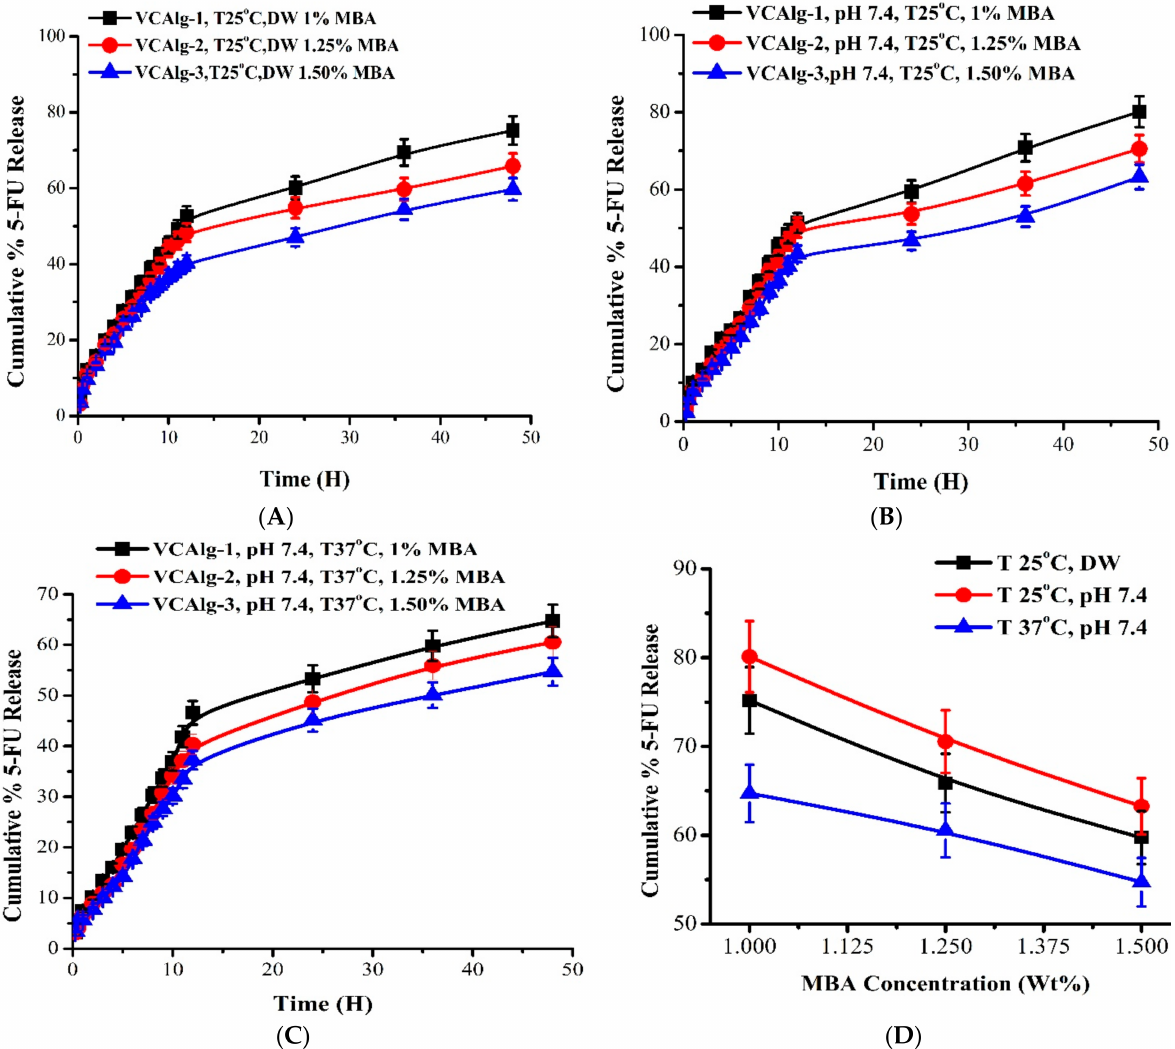
Figure 11. Effect of variable MBA contents on cumulative 5-FU release from Poly (NVCL-g-NaAlg) in situ depot gels with time in DW at 25 ◦ C ( A ), in pH 7.4 (PBS, 5 mM) at 25 ◦ C ( B ), and in PBS (pH = 7.4) at 37 ◦ C ( C ). Cumulative 5-FU release in buffer solutions of variable pH values at different temperature programs with variable MBA contents ( D ). A significant decrease in drug release